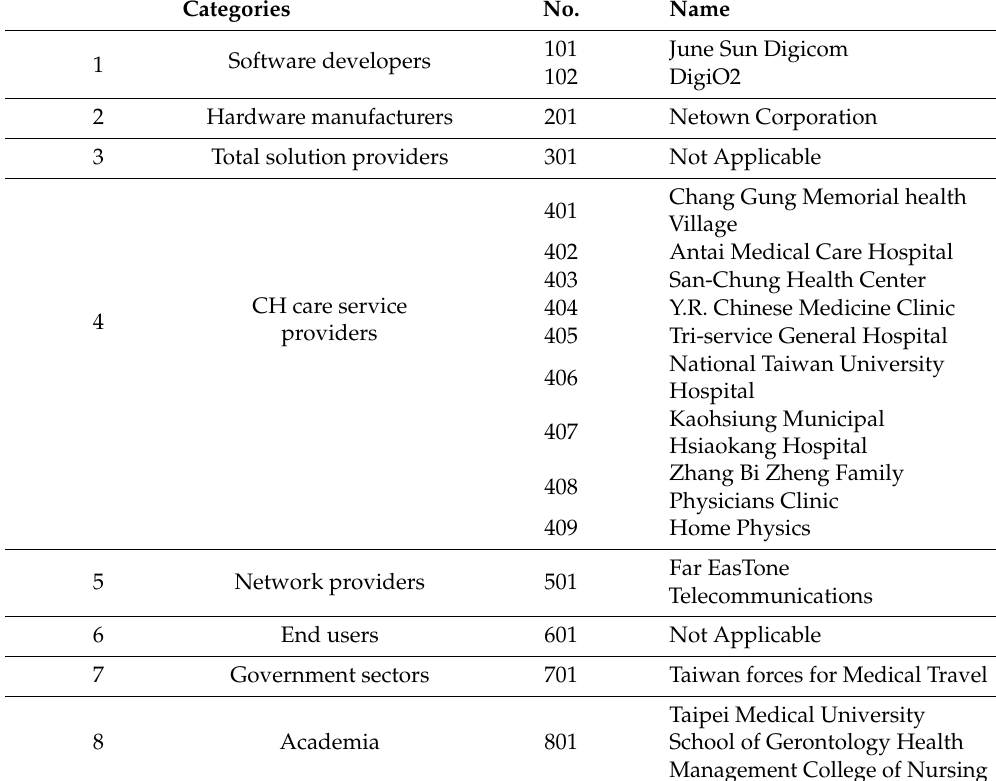
Table 6. Interviewees’ perspectives score in terms of CH issues.